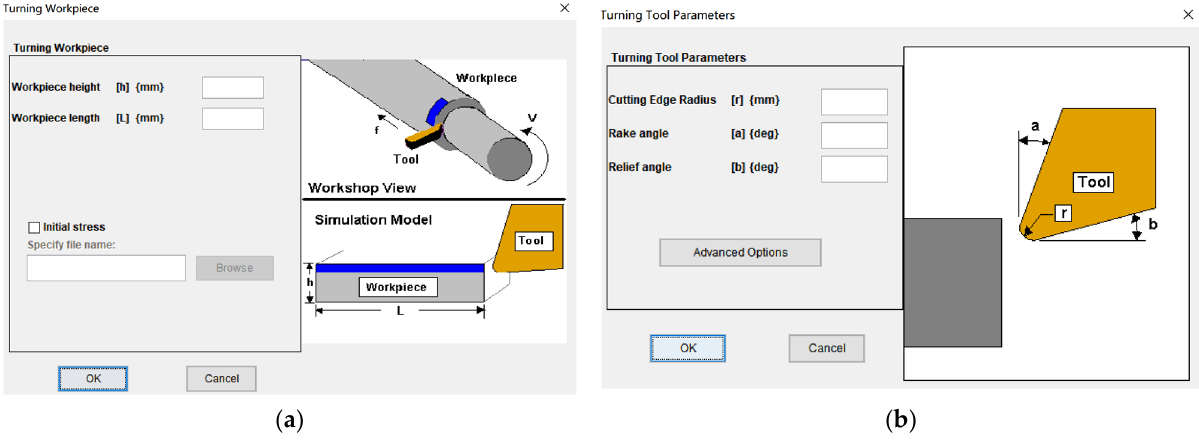
Figure 1. Workpiece–tool parameter se tt ings: ( a ) standard workpiece; ( b ) standard tool. Table 1. Simulation parameters.